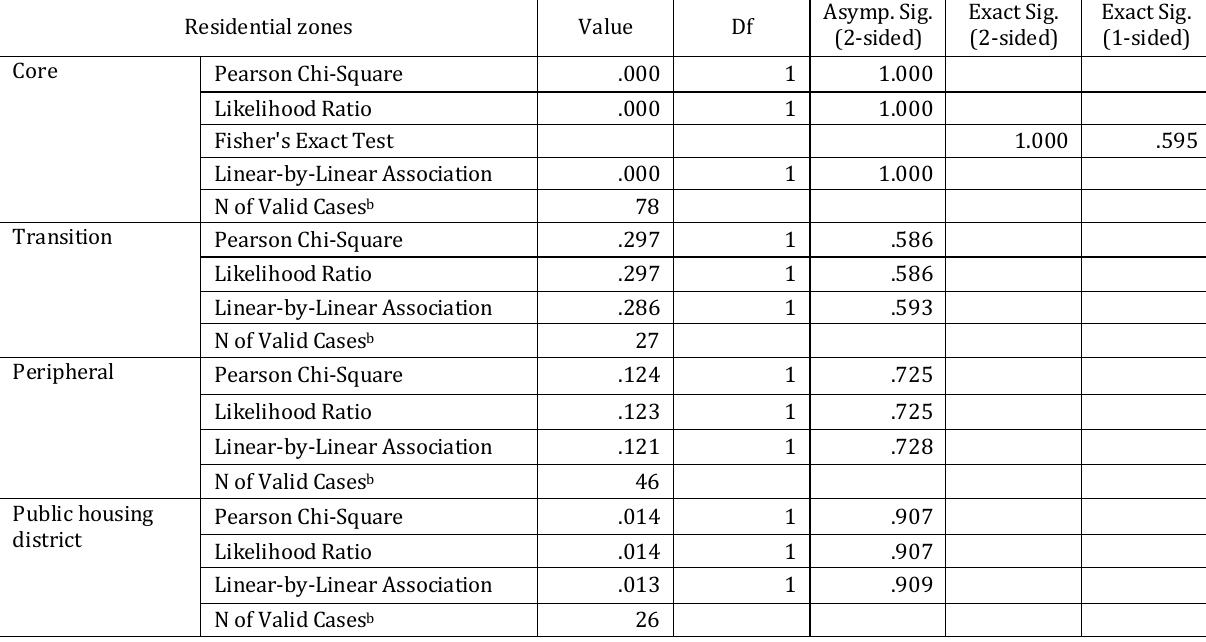
Table 4. Chi-Square summary for providers of boreholes across residential